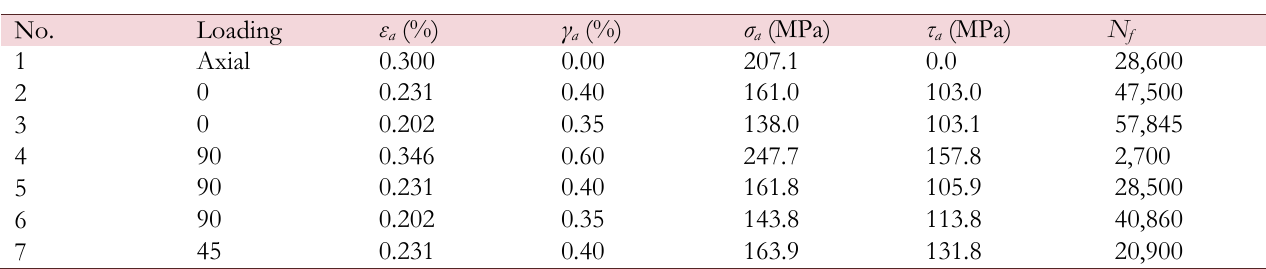
Table 1: Summary of cyclic tests for AlMg4.5Mn [8].